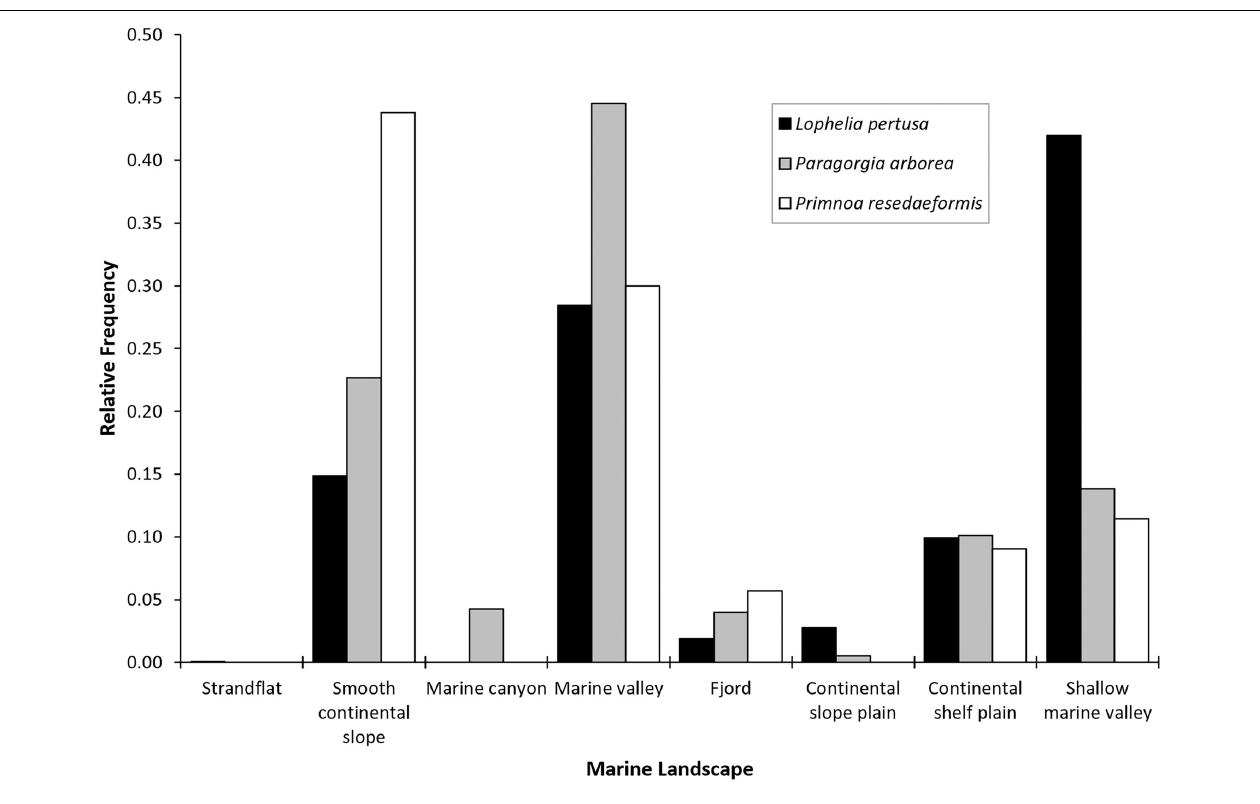
FIGURE 6 | Relative frequency of marine landscape type for each coral species.